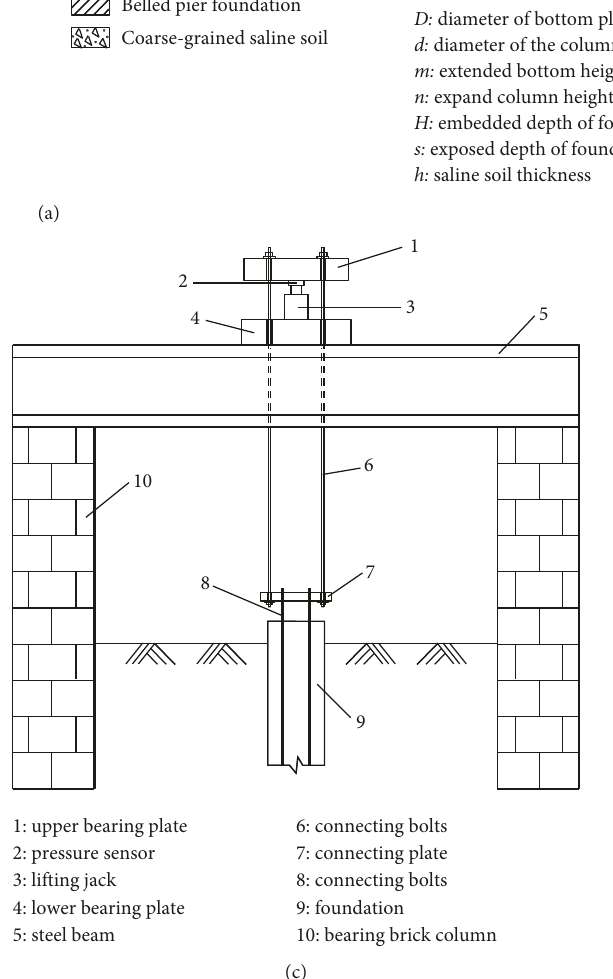
Figure 4: Belled pier foundation in coarse-grained saline soils. (a) Vertical view of the foundation pit. (b) Cross section of the belled pier. (c) Loading